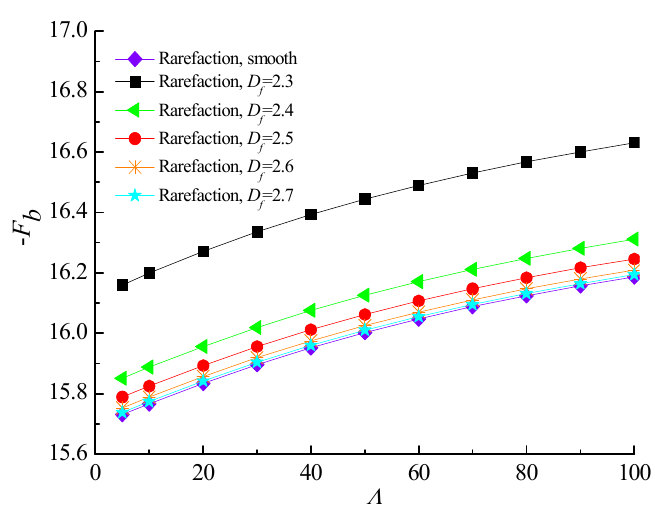
Figure 11. Static friction coefficient versus bearing number for different fractal dimensions at ε = 0.6, G = 1 × 10 −10 .